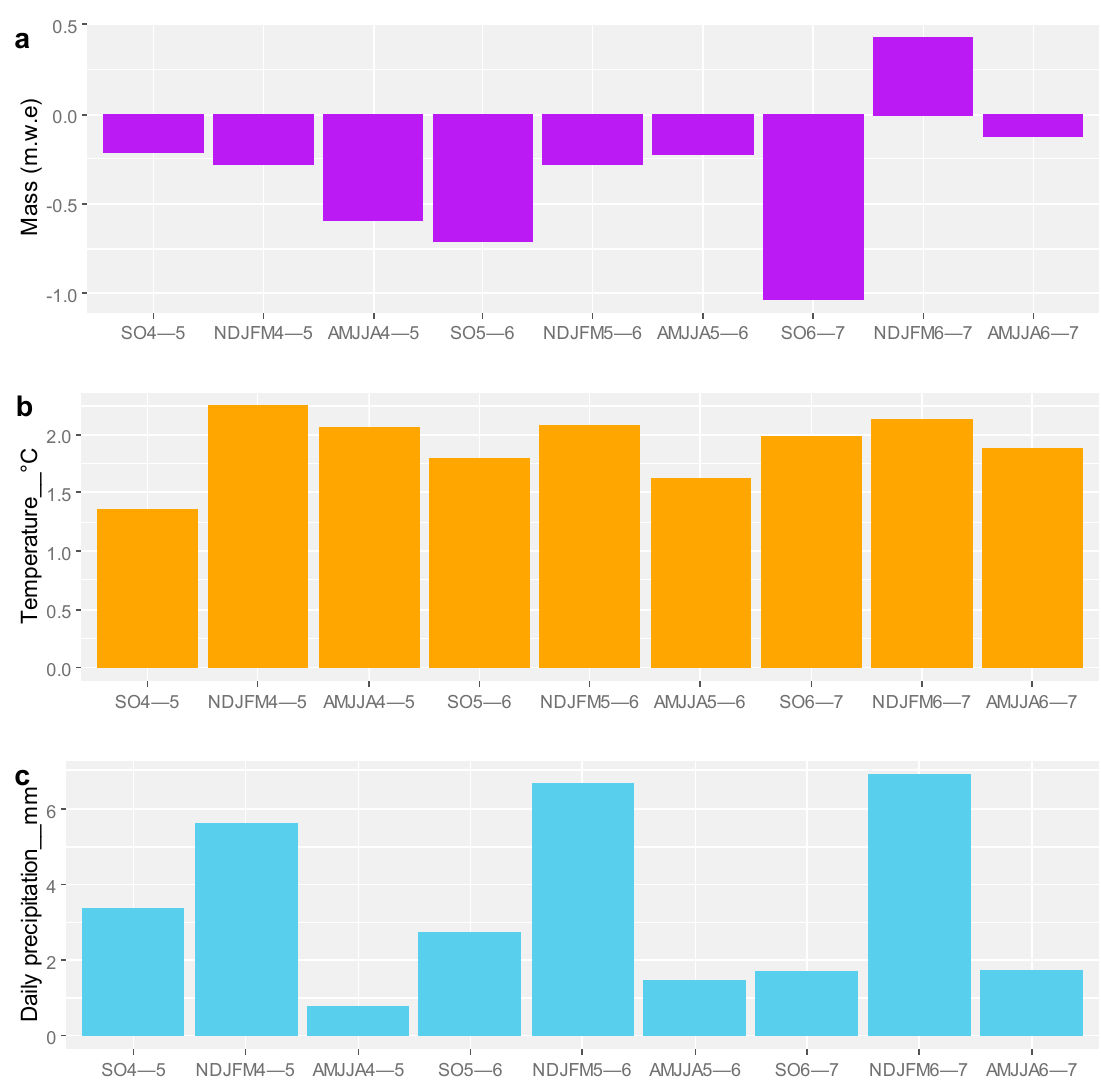
Figure 5. Seasonally averaged daily means of ( a ) simulated mass balance, ( b ) temperature, and ( c ) precipitation over the simulated 2004–2007 hydrological years.